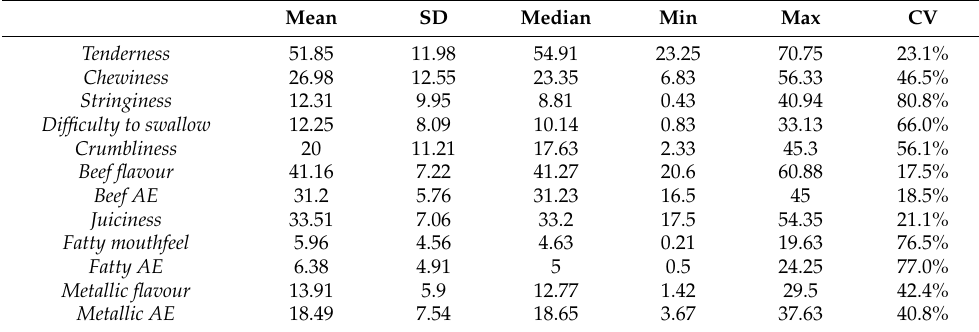
Table 1. Descriptive statistics of twelve beef LTL eating quality traits (sensory scores measured on a scale of